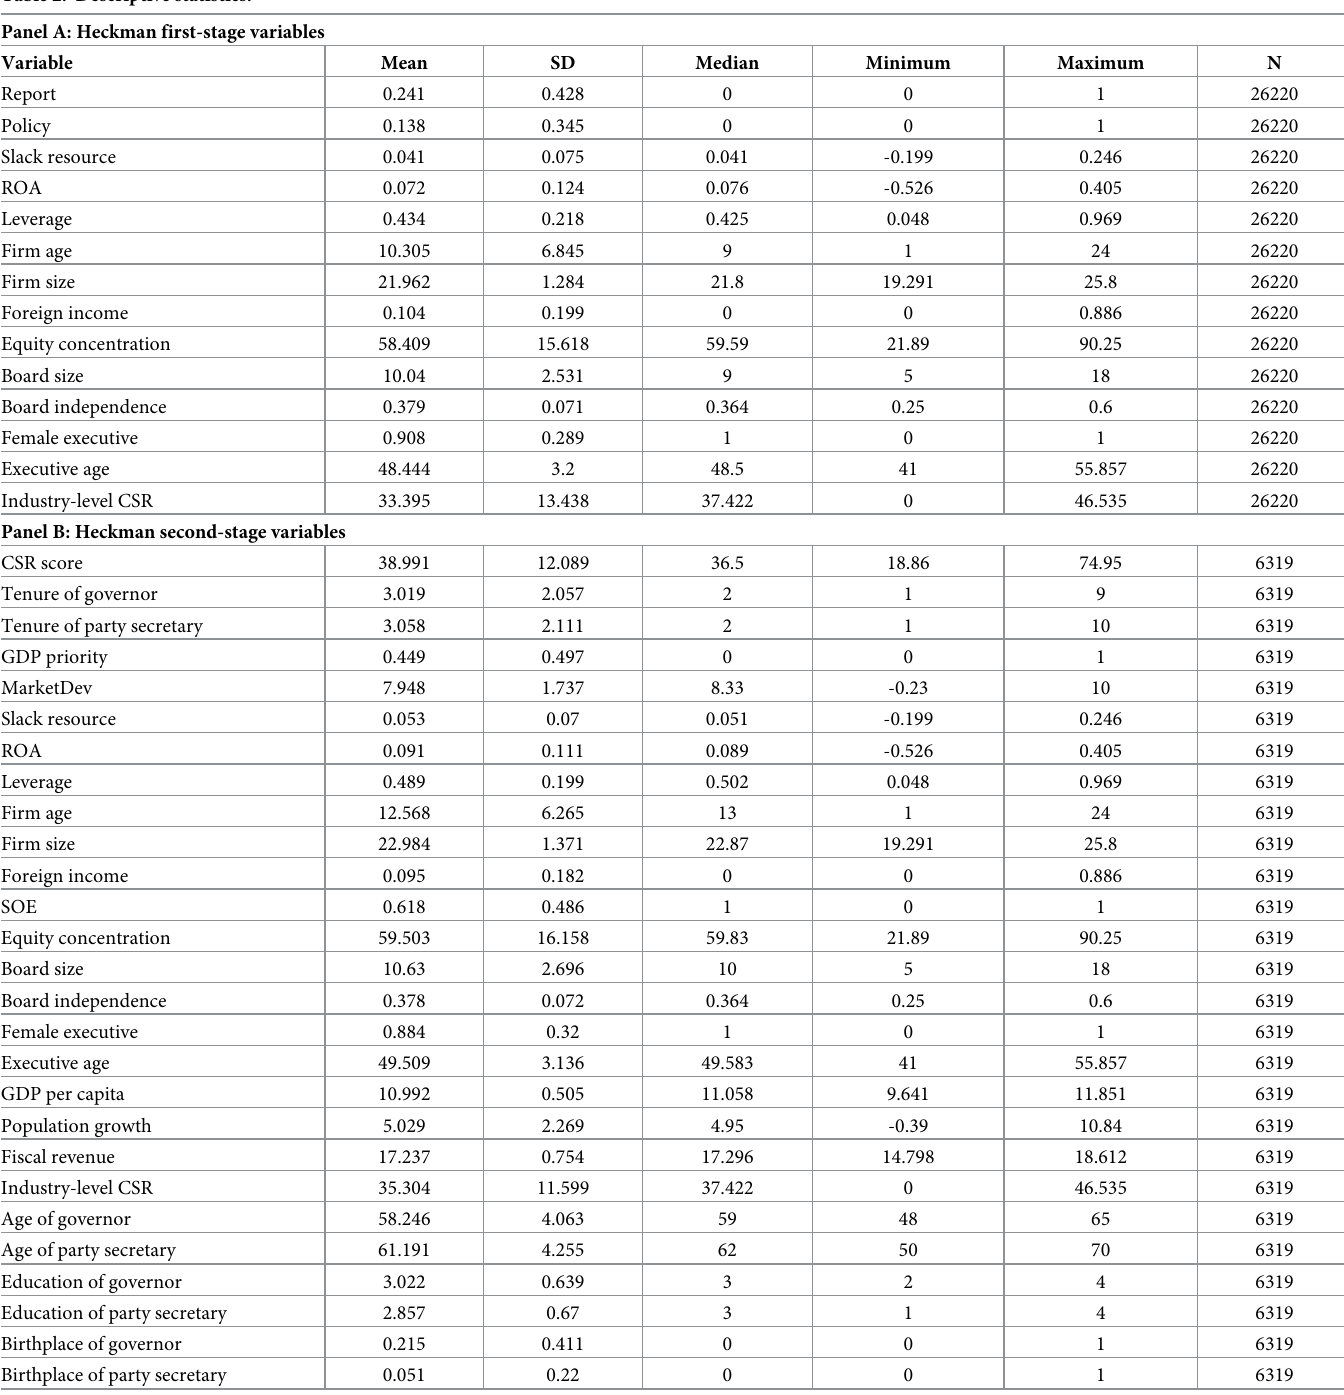
Table 2. Descriptive